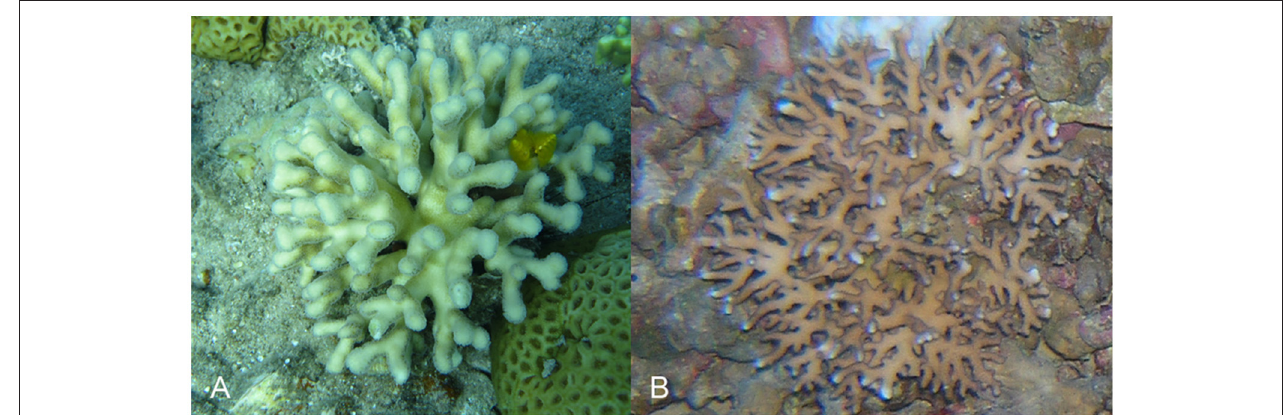
FIGURE 2 | Example of Stylophora pistillata from shallow and mesophotic environments. (A) 3m; (B) 65m.